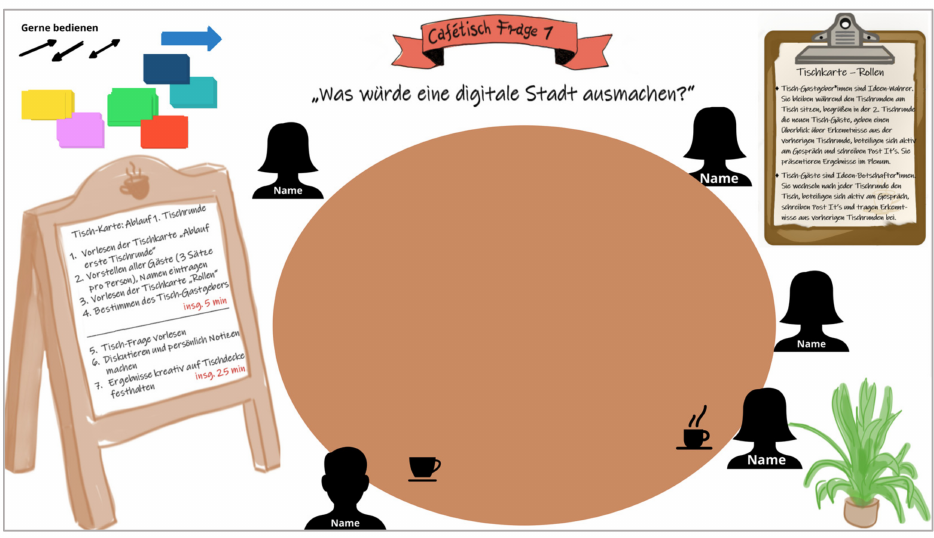
Figure 3. Conceptboard tile “caf é table question